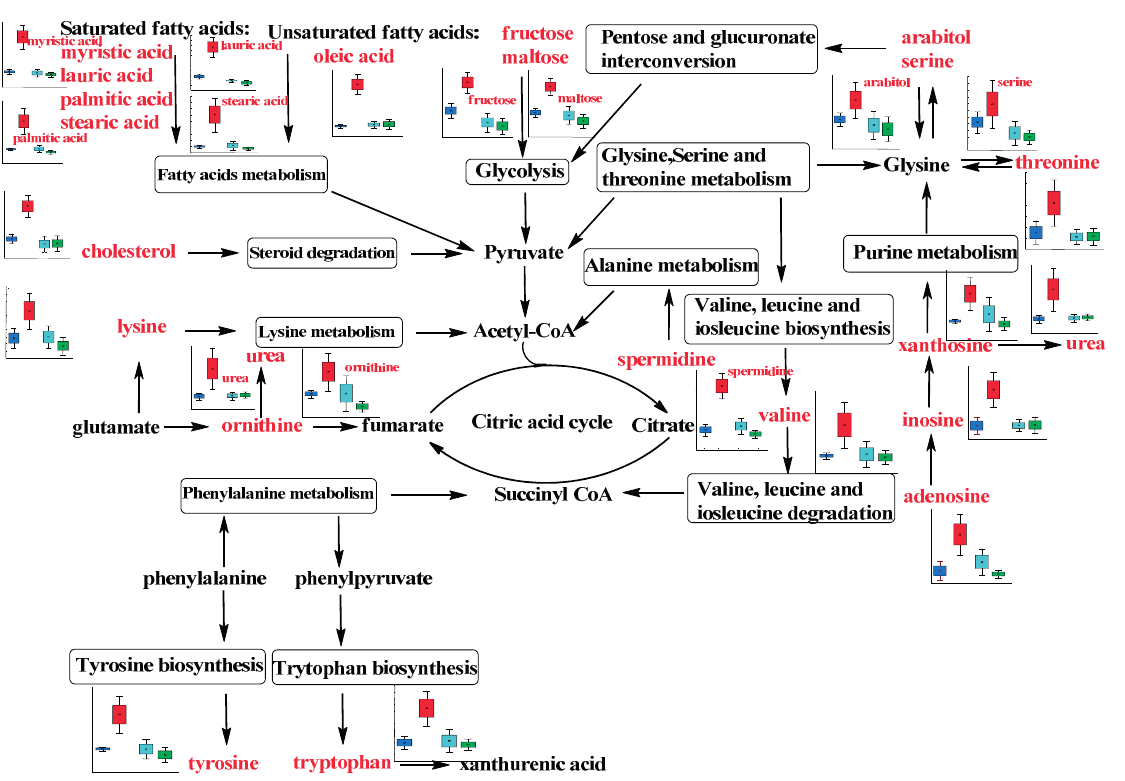
Figure 4. Network of the disregulated metabolites from energy metabolism related pathways from urine samples changing for the CHF, normal control, sham surgery, and SFD-treated groups. Metabolite names in red indicate that they are detected in our study. Box-and-whisker plots of biomarkers were based on ANOVA analysis. Gray color, normal control group; Blue color, sham surgery group; Red color, CHF group; Green color, SFD-treated